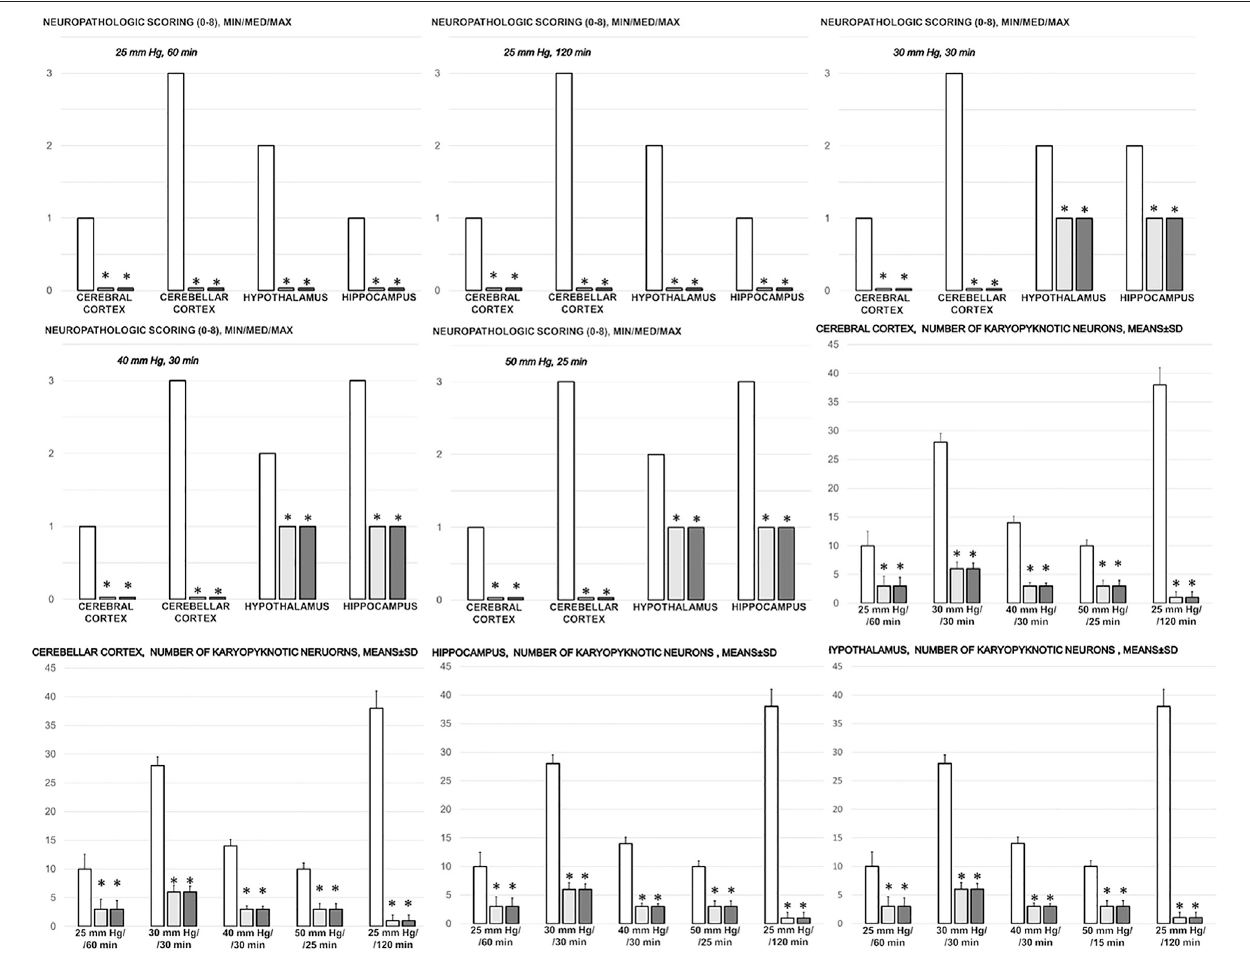
FIGURE 12 | Neuropathologic scoring (0 – 8), cerebral cortex, cerebellar cortex, hypothalamus, hippocampus, and the number of karyopyknotic cells, cerebral cortex, cerebellar cortex, hypothalamus, hippocampus, in the thiopental-anesthetized rats with the increased intra-abdominal pressures at 50 mmHg for 25 min, at 30 mmHg or40 mmHg for 30 min, at 25 mmHg for 60 min increased intra-abdominalpressures-time,and in theesketamine-anesthetizedrats withthe increased intra- abdominal pressures at the 25 mmHg at the 120 min increased intra-abdominal pressures-time, following medication (BPC 157 10 μ g/kg (light gray bars), 10 ng/kg (dark gray bars); saline 5 ml/kg (white bars)) given subcutaneously at 10 min increased intra-abdominal pressures-time. Minimum (min), maximum (max), median (med), means ± SD, *P ˂ 0.05, vs. control.